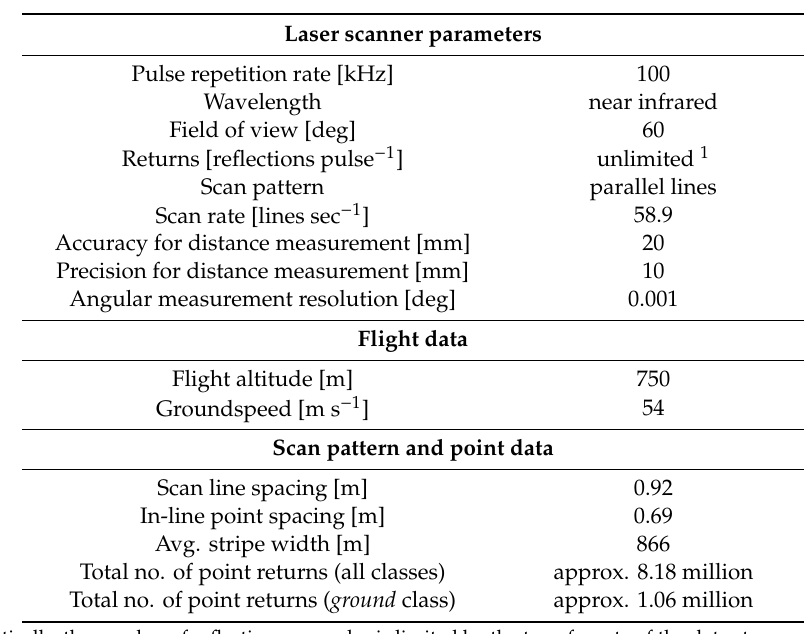
Table 1. Technical data for the Riegl LMS-Q560 laser